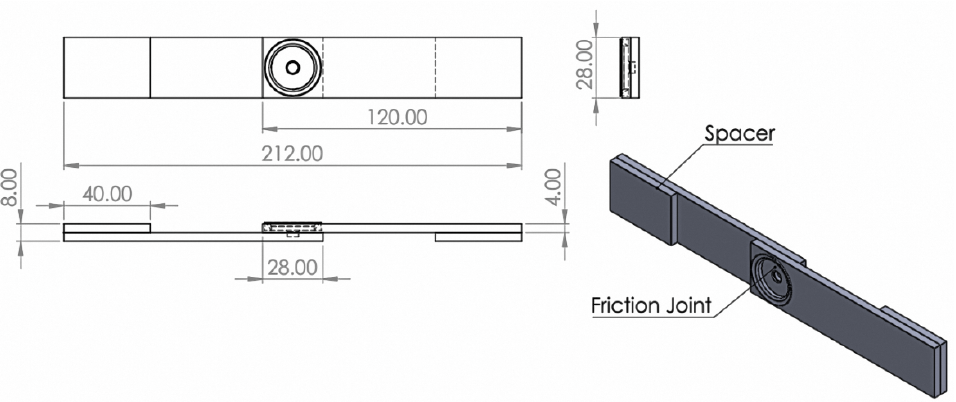
Figure 2. The geometry of the lap joint for the specimens of the experiment made using the FSSW process.